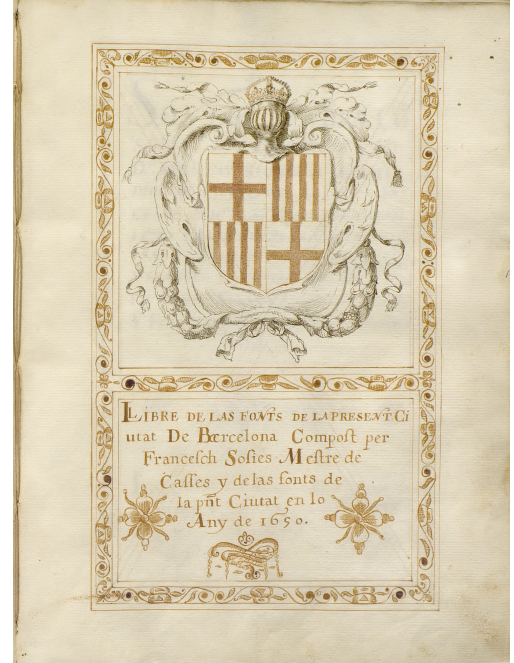
Figure 2. First page of the Llibre de les Fonts , Manuscrits, AHCB1- 002/CCAM 01/1G-076, Arxiu Històric de la Ciutat de Barcelona